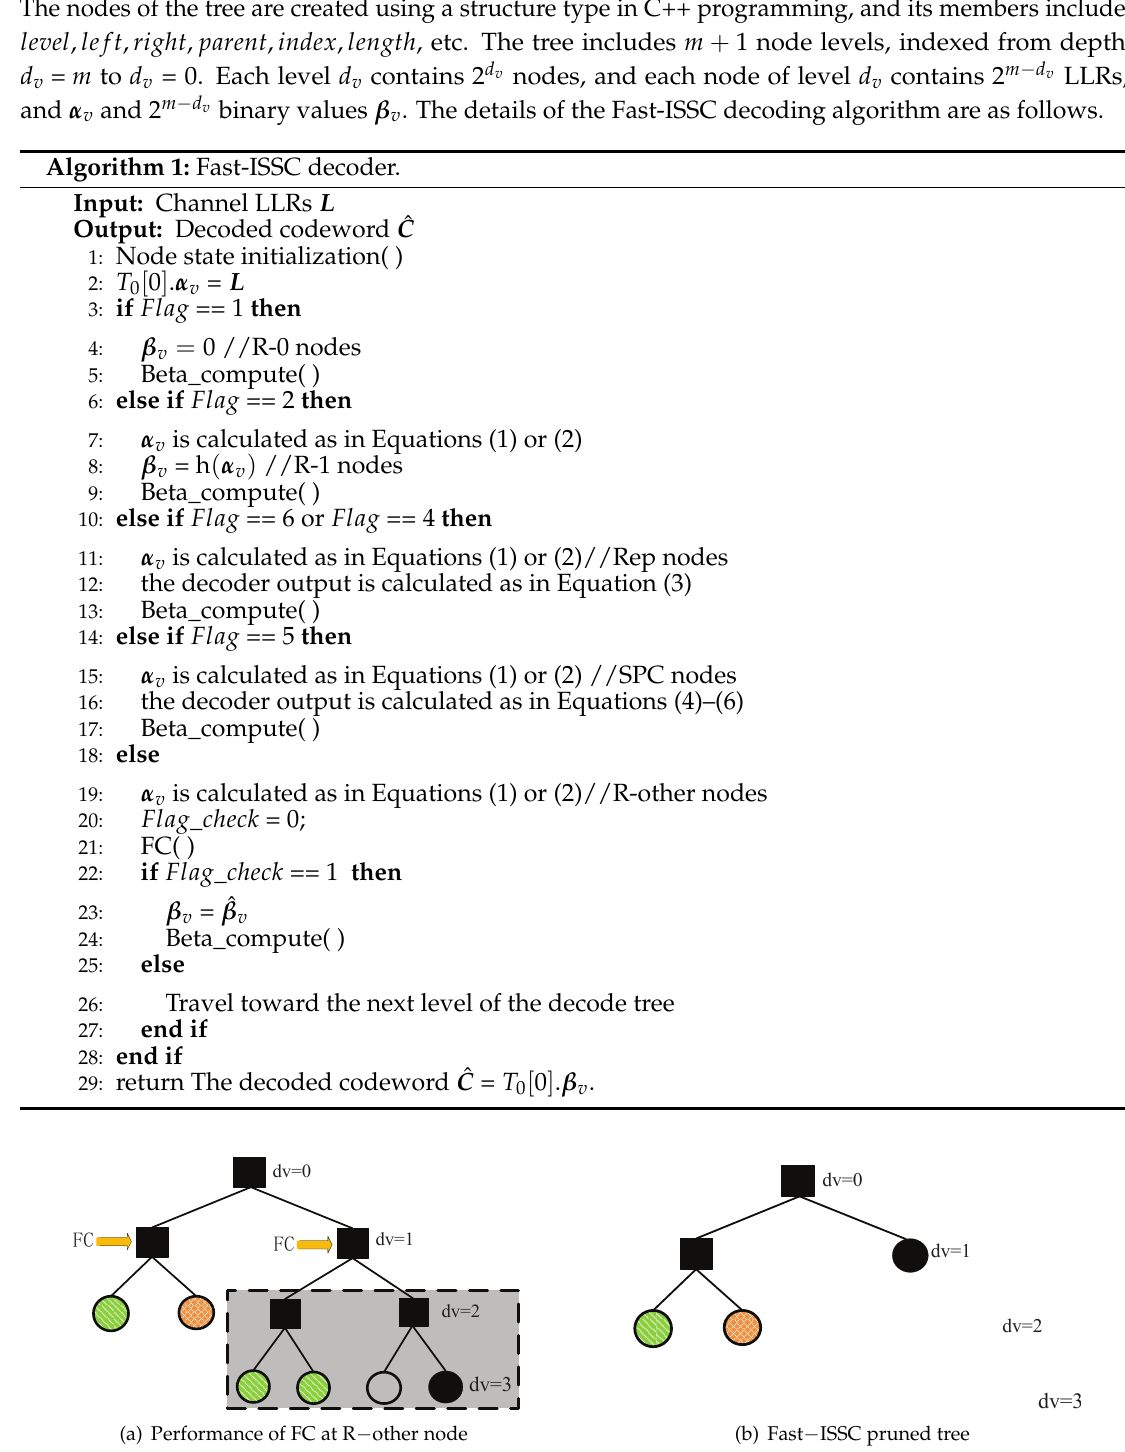
Figure 3. Example of Fast-ISSC pruned tree based on FC performance at R-other node for P(16,